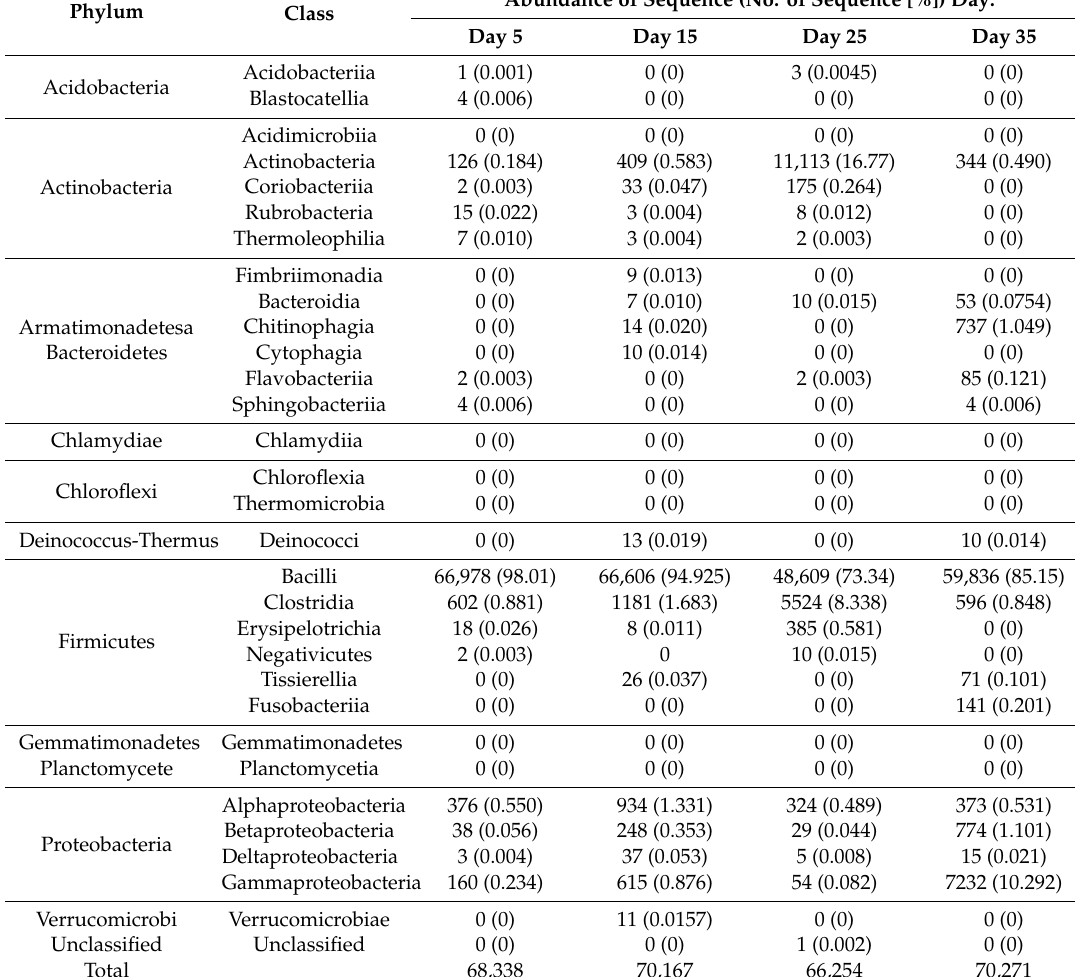
Table 1. Abundance of bacterial 16S rDNA sequences ( n = 275,030) identified from the duodenum microbiota of Cobb 500 broiler